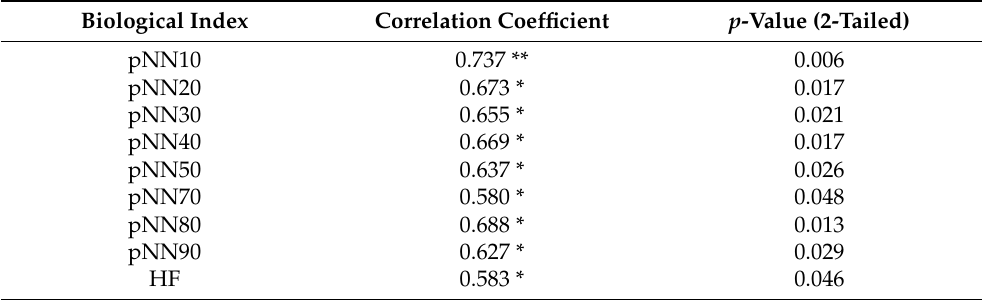
Table 8. Correlation coefficients between the number of errors in Task1 and the mean values of biological indexes during Rest1 (the pre-error condition) (* correlation is significant at the 0.05 level; ** correlation is significant at the 0.01 level).